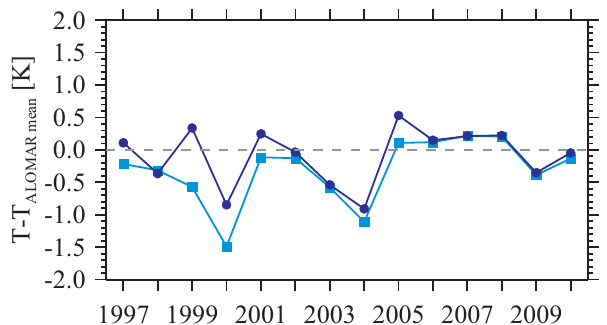
Fig. 10. Seasonal mean sampling of temperature at 83km alti- tude during ALOMAR RMR-lidar measurements as determined by LIMA. Temperatures calculated solely for hours with lidar mea- surements are compared to entire means from 1June to 15August. Sampling curves are calculated for two data sets: long-term (blue circles) and high-sensitivity (light blue